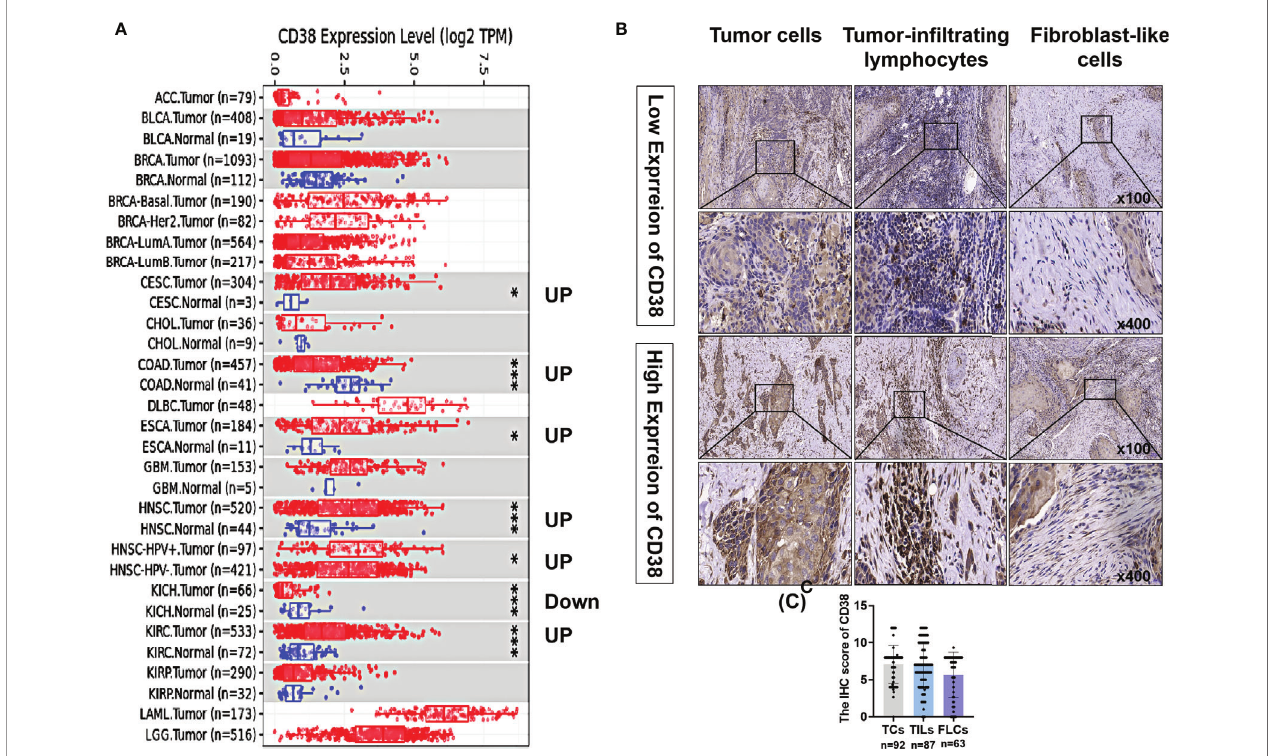
FIGURE 1 | Expression levels of CD38 in OSCC and other cancers. (A) The CD38 expression in different tumor types with or without normal tissues with TIMER and the statistical signi fi cance was marked by the number of stars. (B) Typical IHC staining of CD38 of OSCC in TCs, FLCs, and TILs. (C) The IHC score of CD38 in TCs, FLCs, and TILs from OSCC patients. * and *** represented that differences were considered statistically signi fi cant with P < 0.05 and P < 0.001, respectively.